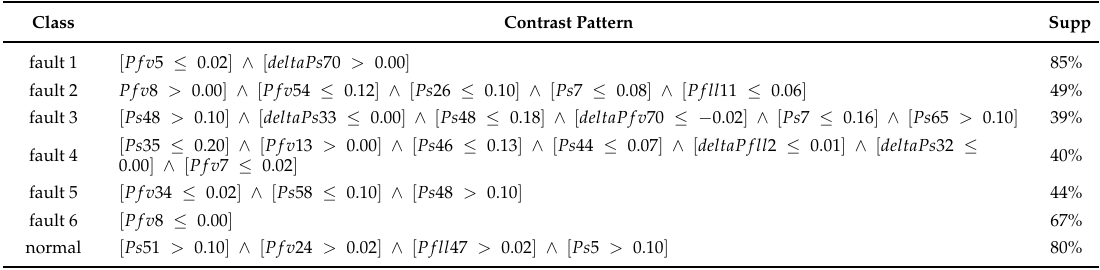
Table 5. Examples of contrast patterns extracted from our proposed database by using PBC4cip.